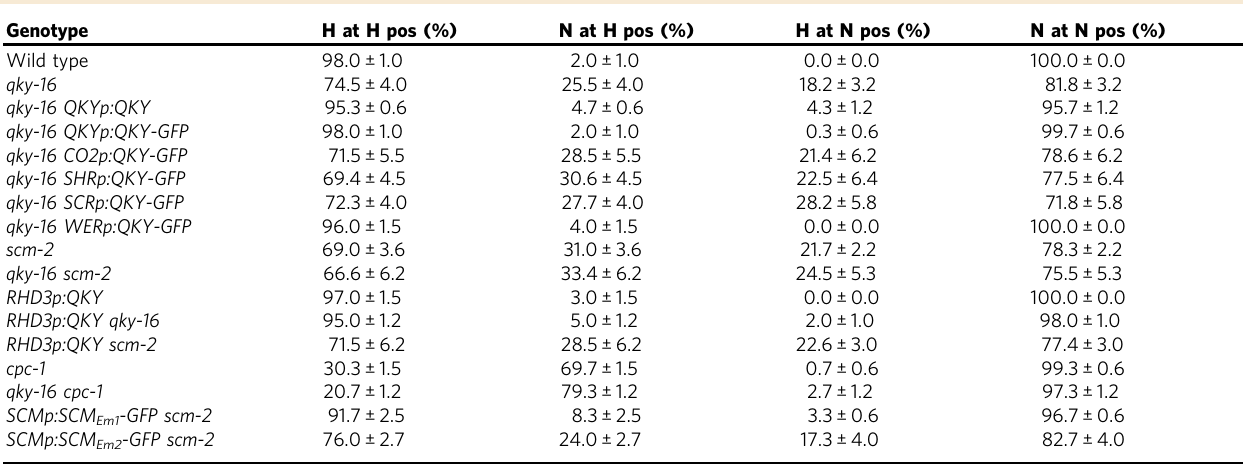
Table 1 Speci fi cation of cell types in the root epidermis Genotype H at H pos (%) N at H pos (%) Wild